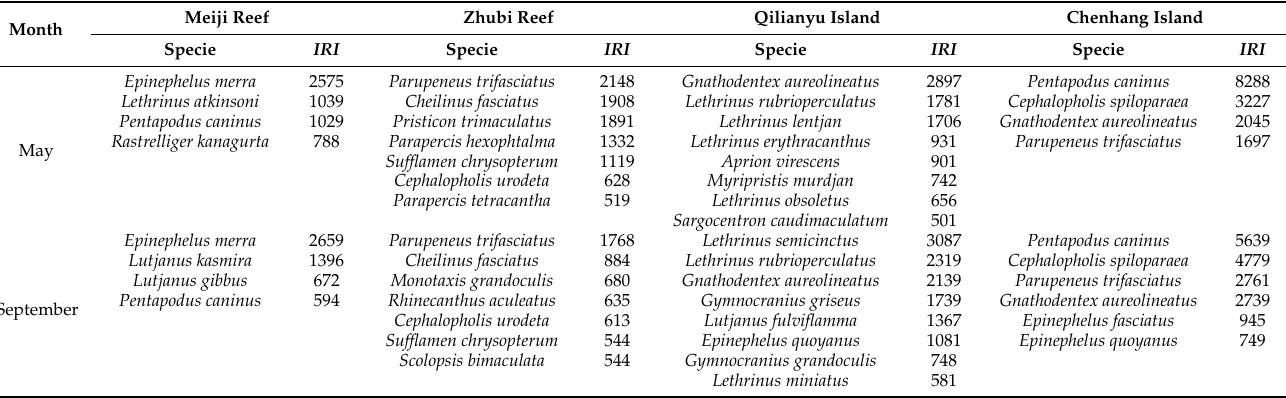
Table 2. Dominant species at four coral reefs in the South China Sea in different seasons.